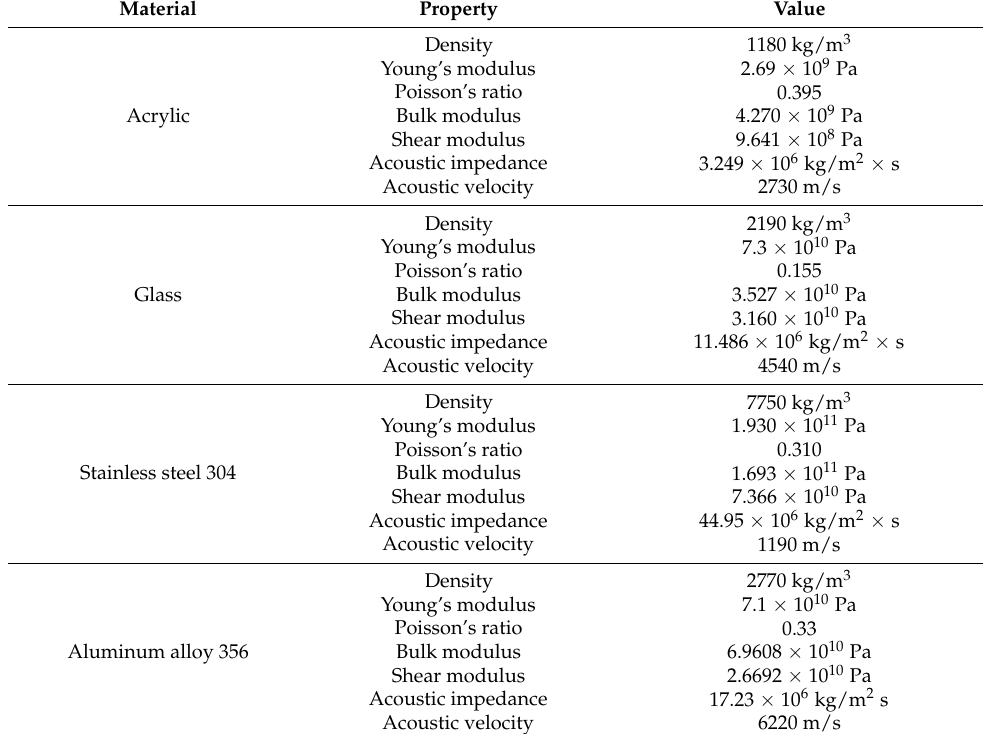
Table 1. Material properties for the HRA simulation (data from Refs.